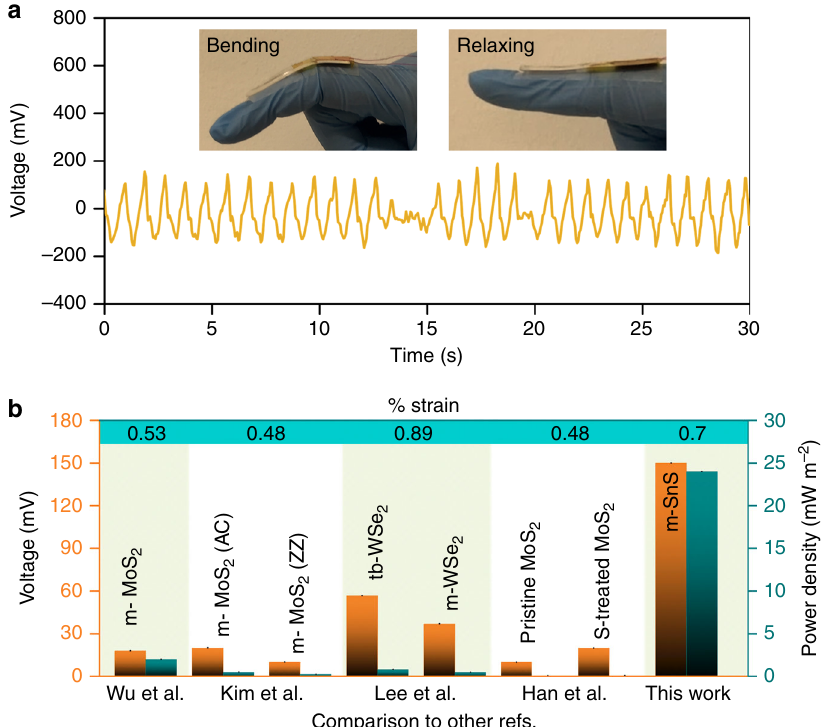
Fig. 5 The output of the device with synthesised monolayer SnS on a fl exible substrate in d 11 mode. a Output measurement in a practical wearable device application. The voltage output of tensile bending and relaxing mode action as depicted in the inset (two-electrode device), b a graph showing a comparison of voltage and power density outputs of previous 2D-based piezoelectric nanogenerators 6,8,9,30 reported in comparison to our work in normalised strain (m-monolayer, S-sulphur-and